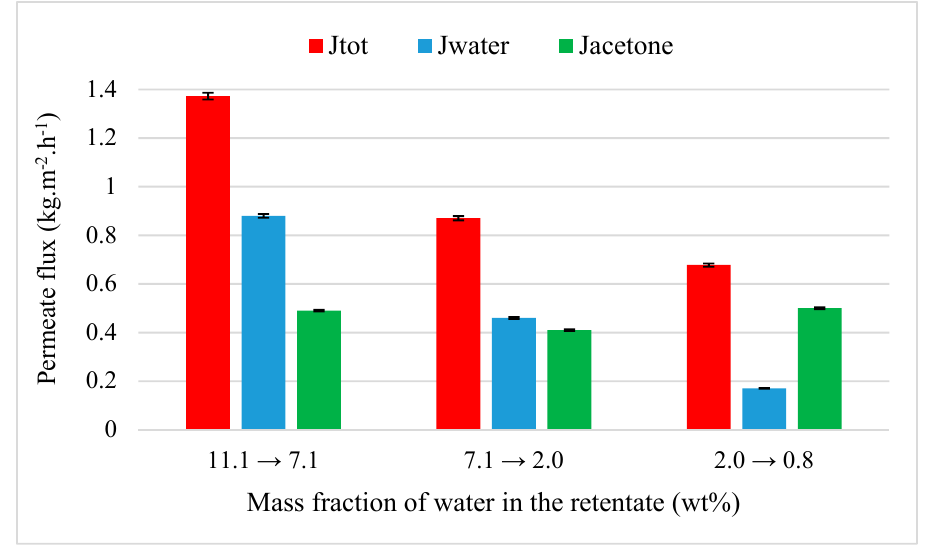
Figure 3. Evolution of flux as the function of the inlet composition from a binary acetone-water mixture (90 / 10 wt%) through M1 depending of temperature: ( a ) 30 ◦ C; ( b ) 45 ◦ C.